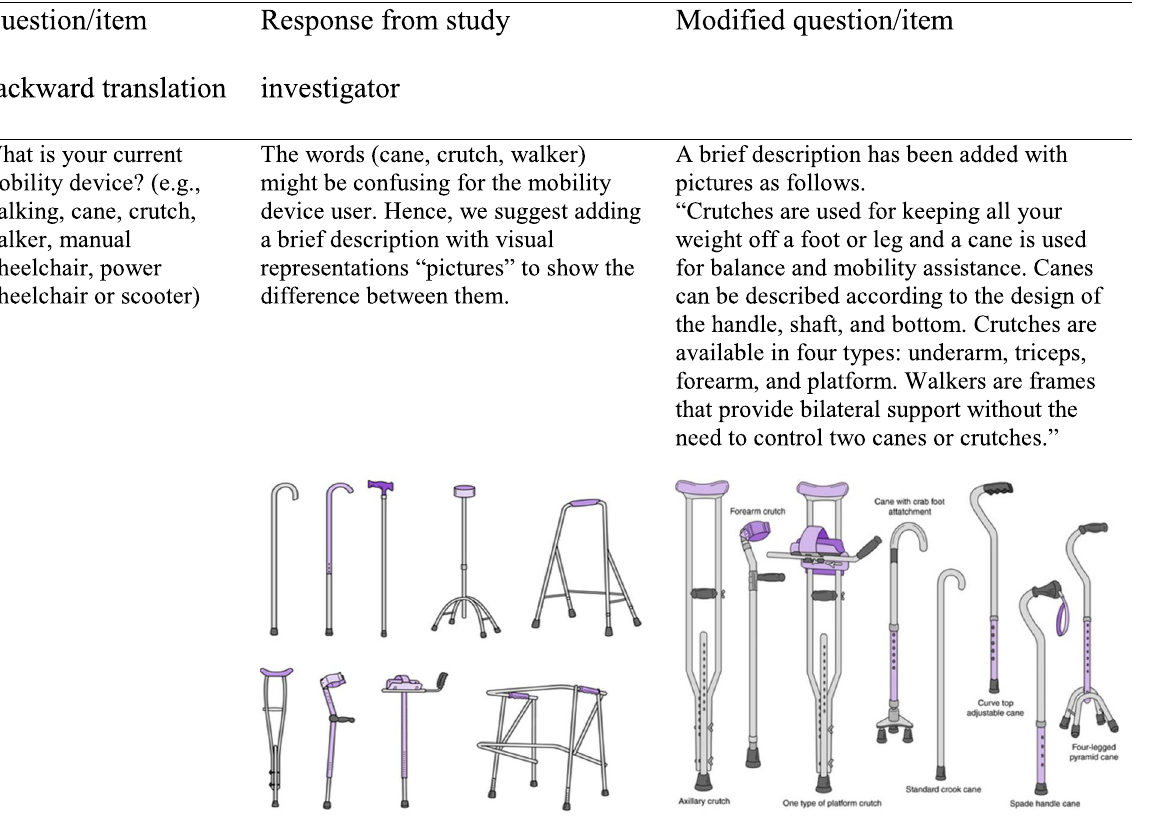
Table 3 Modifications to some questions and items in the functional mobility assessment (FMA) following the backward translation of the